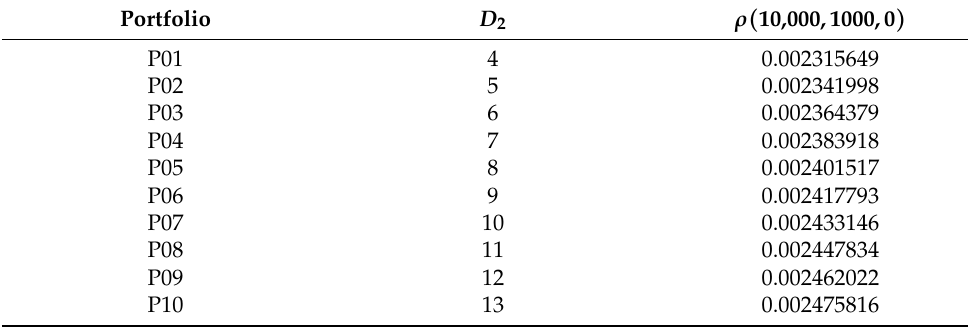
Table 6. Cases 2.1—Impact of the lifetime distribution on the risk index.